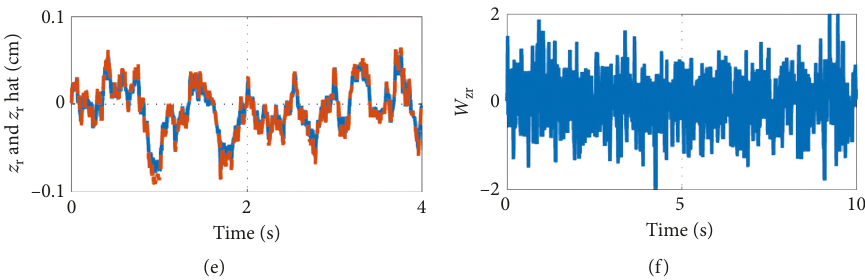
Figure 15: The real states (solid line) and estimated states using SPKF (dotted line) in the case of 60km/h. (a) z dt hat. (c) z w and z w hat. (d) dz w / dt and dz w / dt hat. (e) z r and z r hat. (f) w